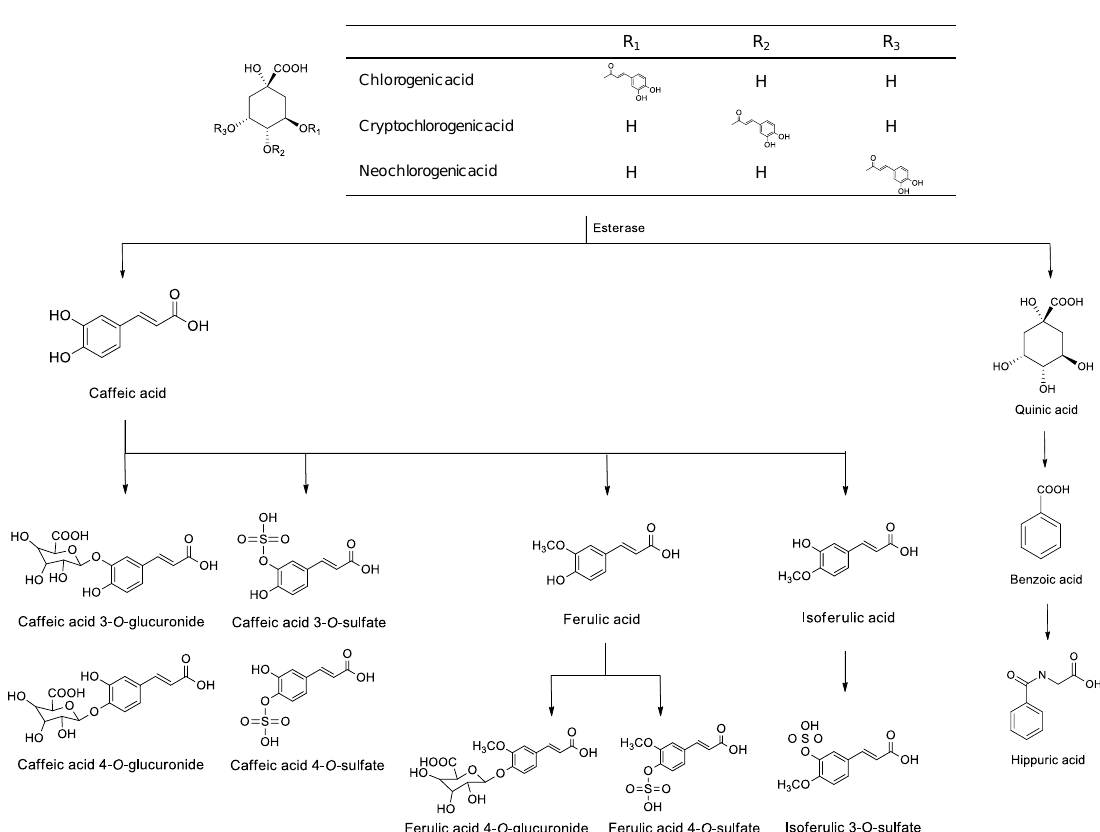
Figure 1. Metabolic pathways of chlorogenic acid, neochlorogenic acid, and cryptochlorogenic acid in rats and humans.